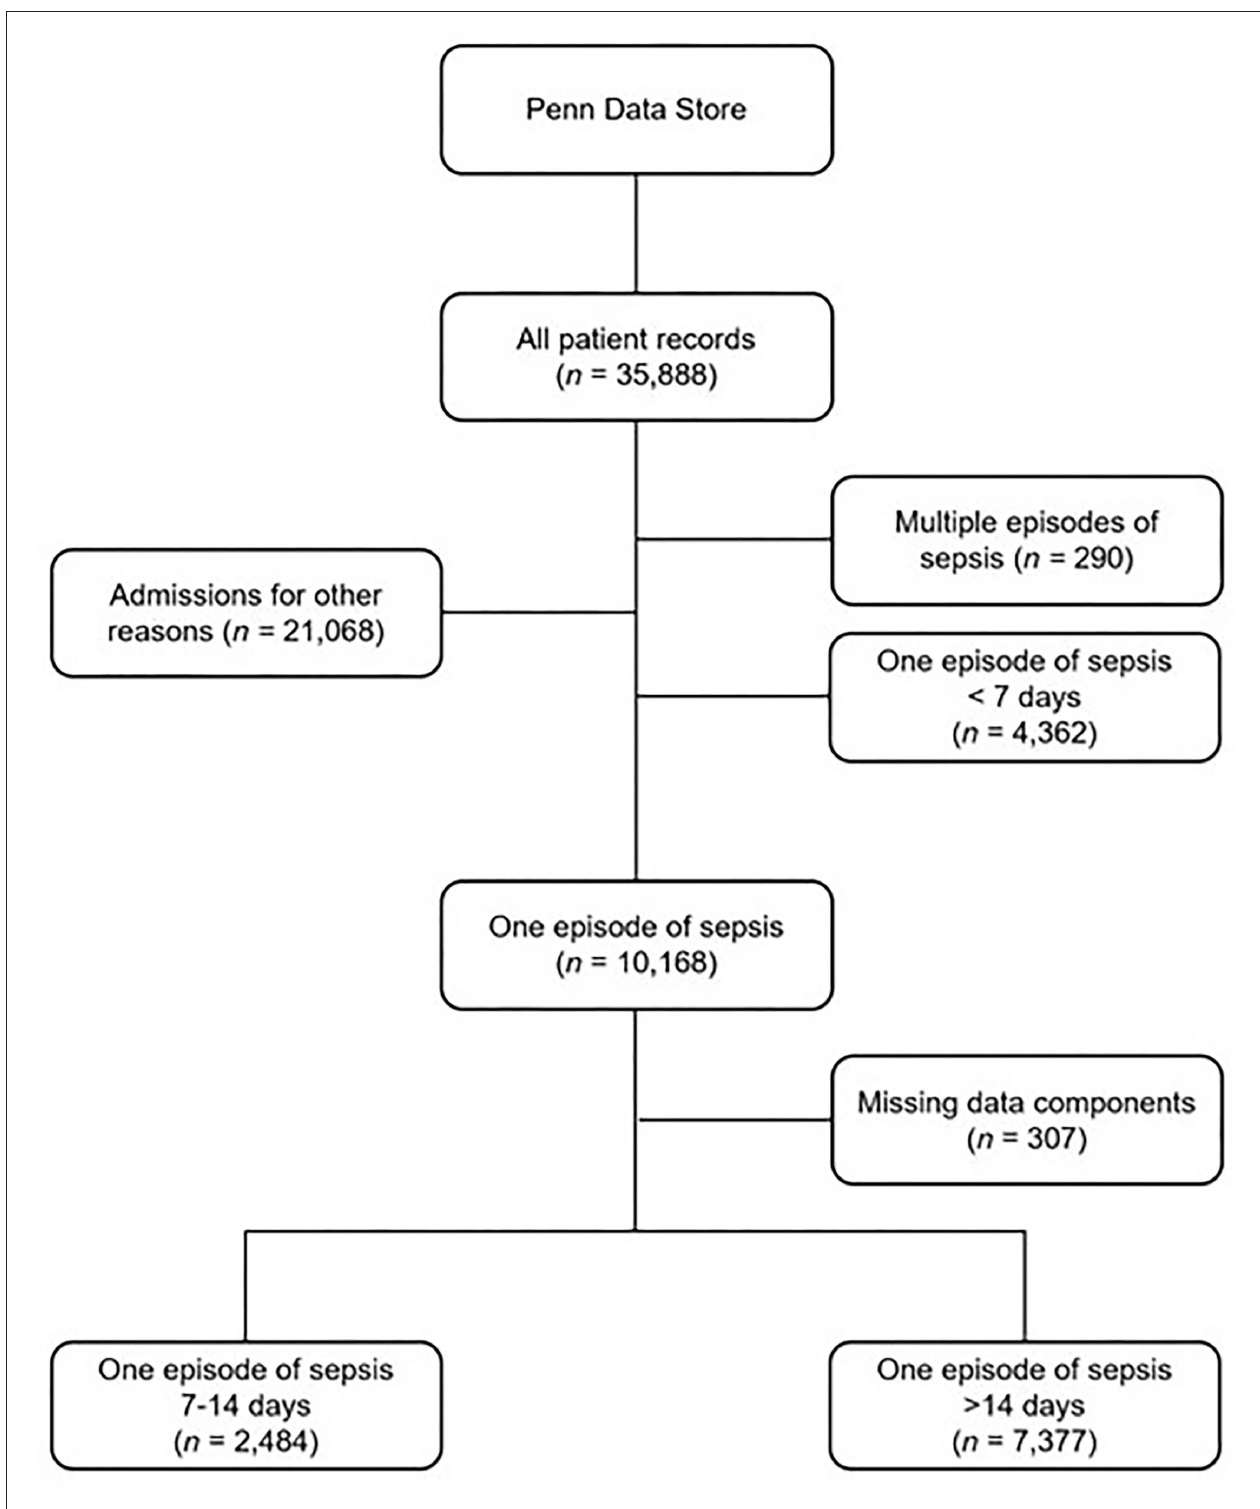
FIGURE 1 | Processing of the electronic medical records (EMR) for the acquisition of the dataset.